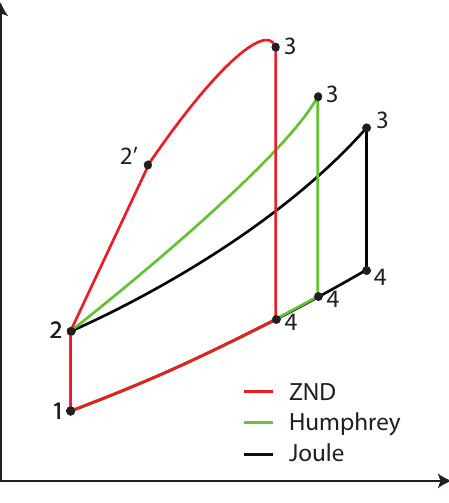
Figure 1. T-s diagrams of the Joule, Humphrey and ZND